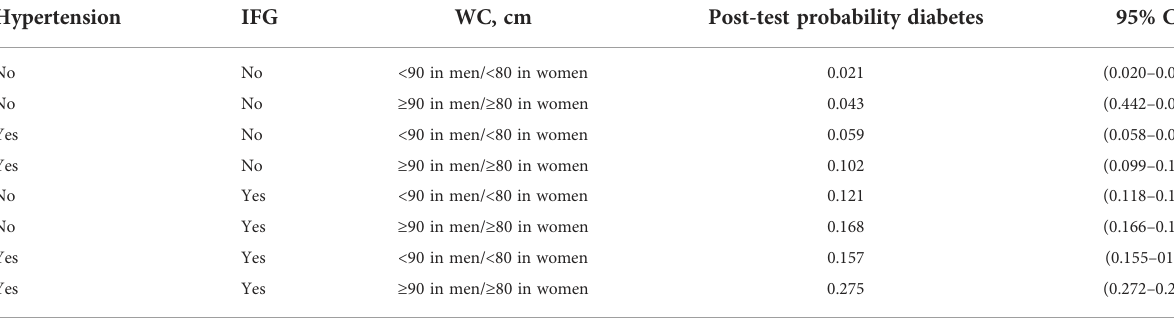
TABLE 2 Post-test probability table of the deterministic nodes in all participants. Hypertension IFG WC, cm Post-test probability